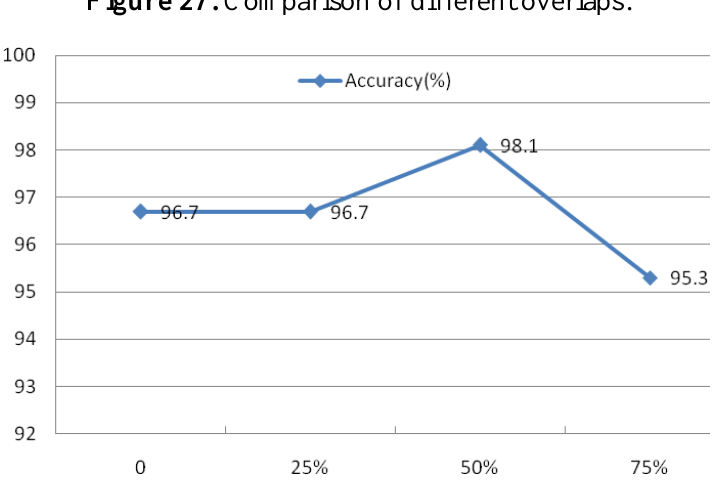
Figure 27. Comparison of different